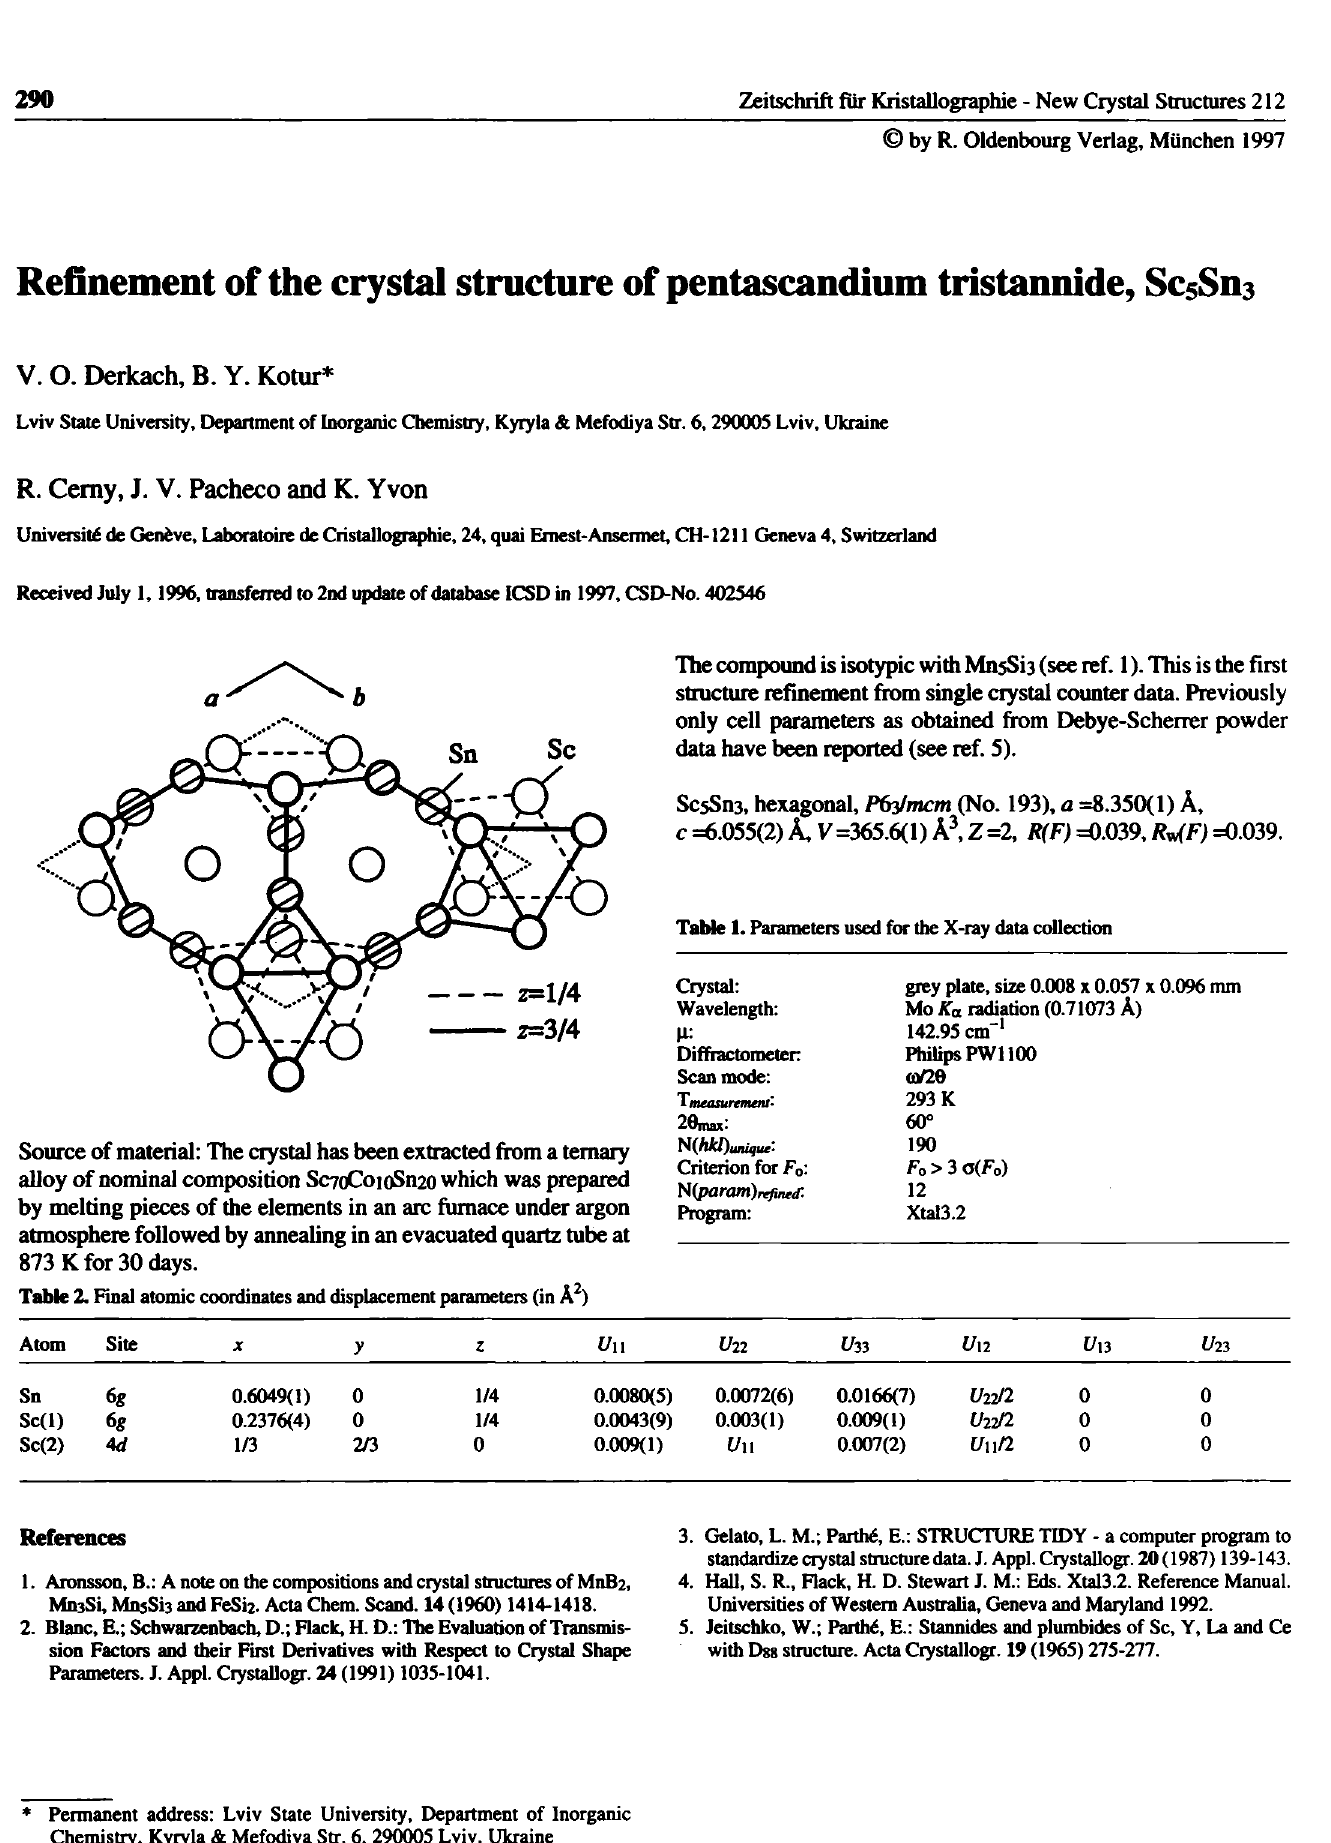
Table 2. Final atomic coordinates and displacement parameters (in Â 2 )